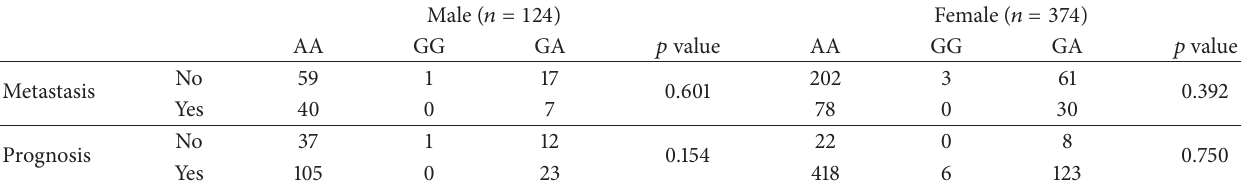
PTC: papillary thyroid